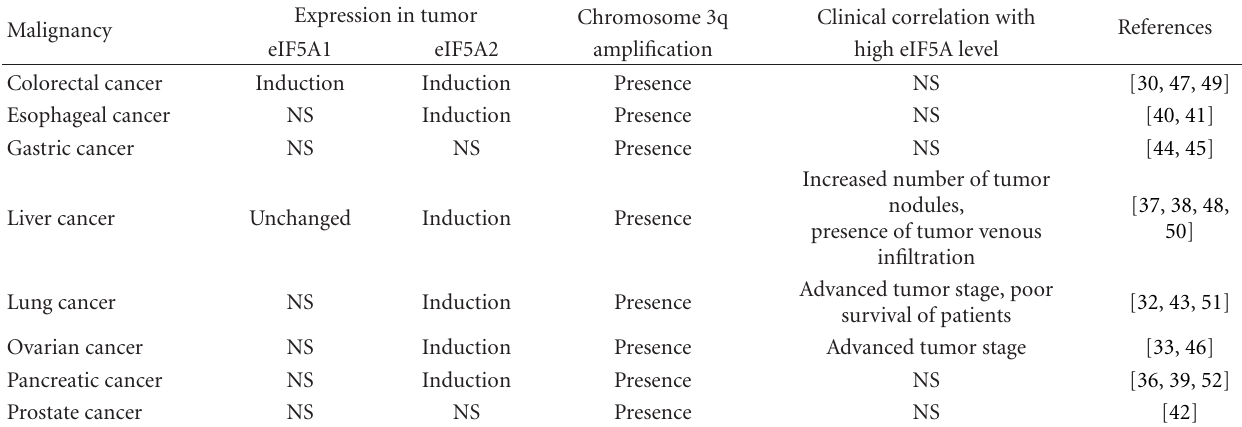
Table 2: Aberrant expression of eIF5A1 and eIF5A2 in di ff erent human